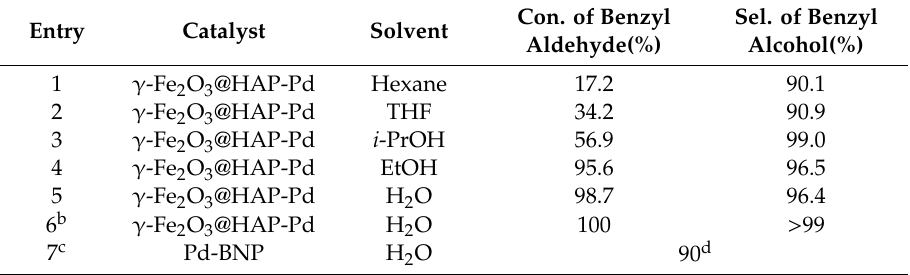
Table 1. Results of the hydrogenation of benzyl aldehyde in di ff erent solvents a .